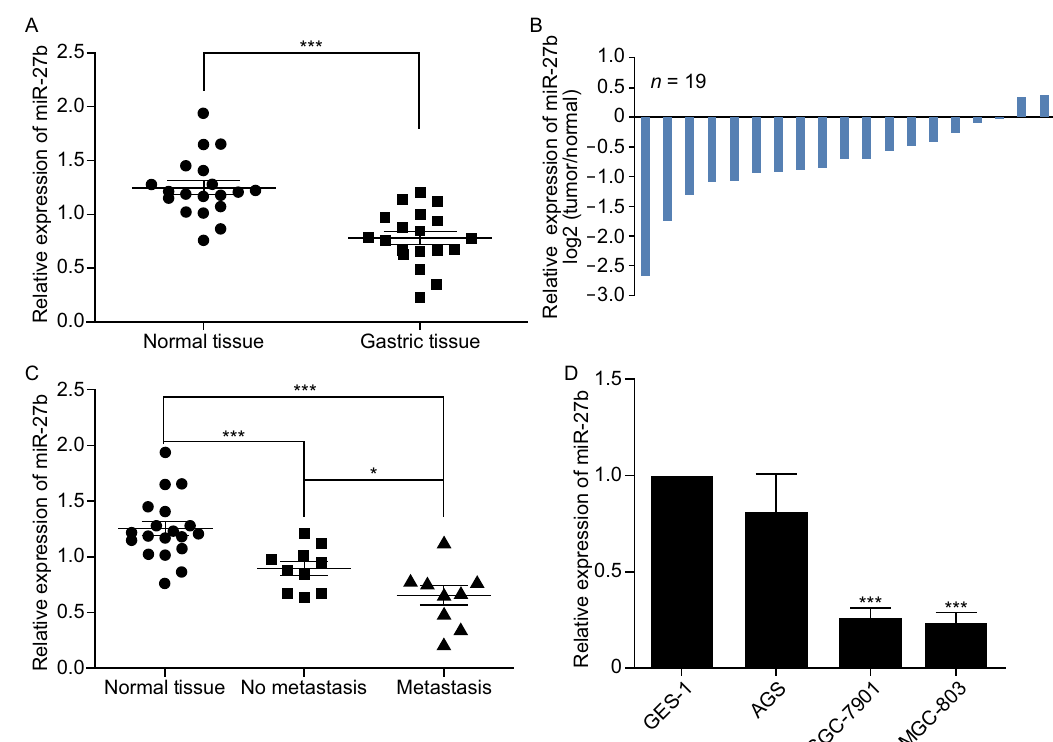
Figure 2. miR-27b is downregulated in human gastric cancer tissues and metastatic gastric cancer cell lines. (A) The expression of miR-27b in human gastric cancer tissue samples and matched normal tissues from 19 gastric cancer patients was analyzed by real-time PCR. (B) miR-27b were expressed as log2 fold change to show the relative expression in every paired sample. (C) Correlation between the lymph node metastasis status and the level of miR-27b in gastric cancers (n = 19). (D) The expression of miR-27b in gastric cancer cell lines with different metastatic potentials was analyzed by real-time PCR. Scale bars, 100 μ m. * P < 0.05, ** P < 0.01, *** P